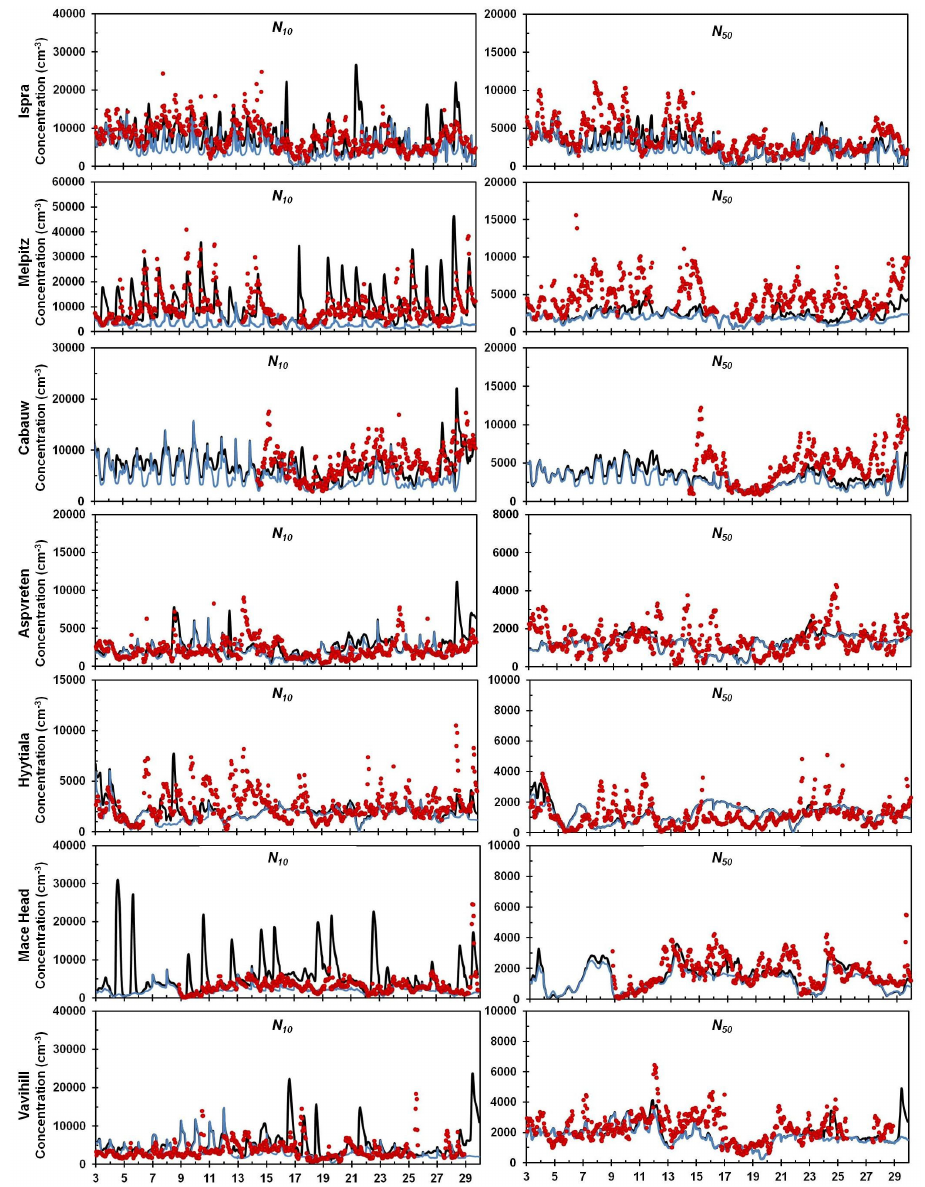
Figure 4. Timeseries comparison of predicted (ternary mechanism: black line, Fig. 4. Timeseries comparison of predicted (ternary mechanism: black line, nucleation turned off: blue line) vs. observed (red dots) particle nucleation turned off: blue line) vs. observed (red dots) particle number number concentrations (cm − 3 ) above 10 and 50nm in 7 measurement stations during May 2008. Different scales are concentrations (cm -3 ) above 10 and 50 nm in 7 measurement stations during May 2008. Different scales are used.